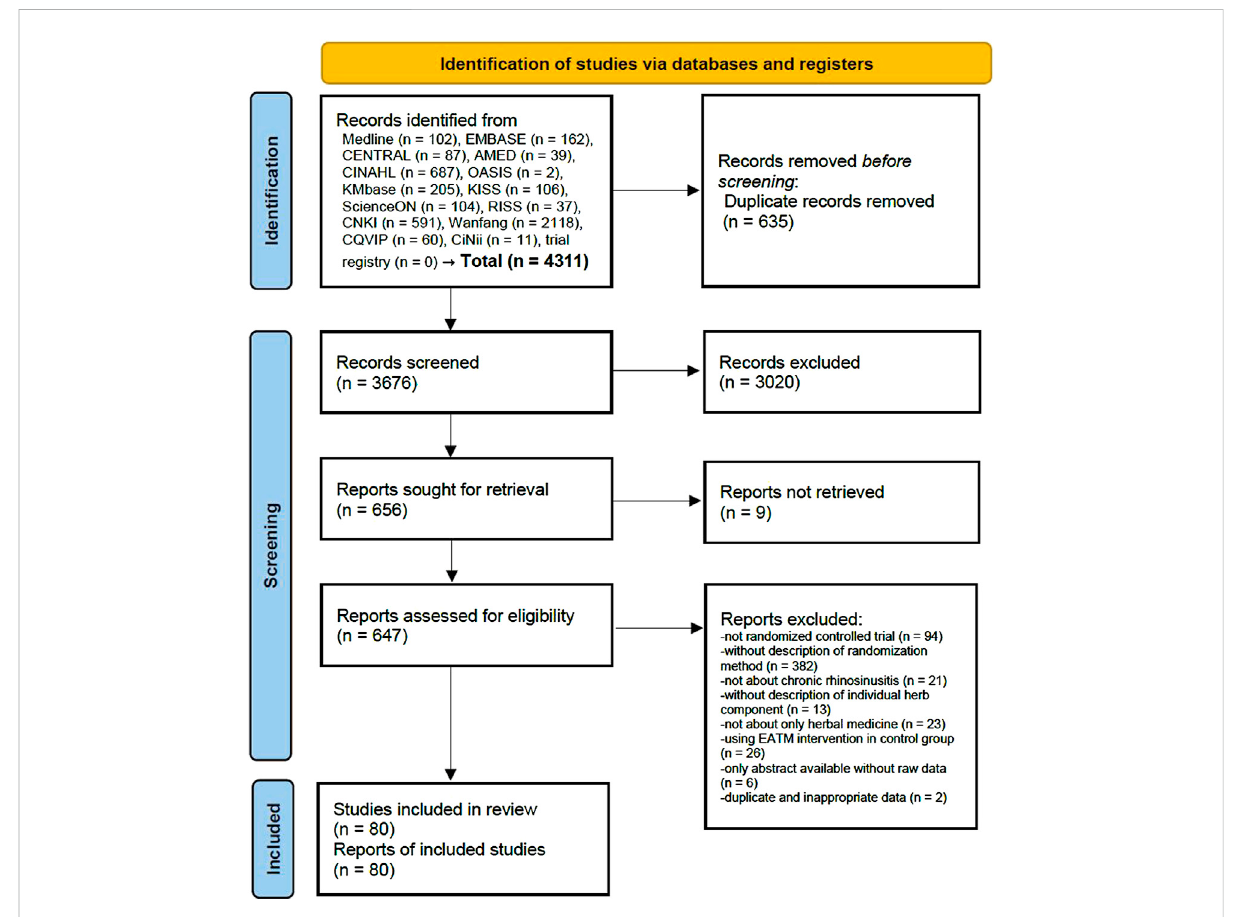
FIGURE 1 PRISMA 2020 fl ow diagram. No studies were identi fi ed from the search of reference